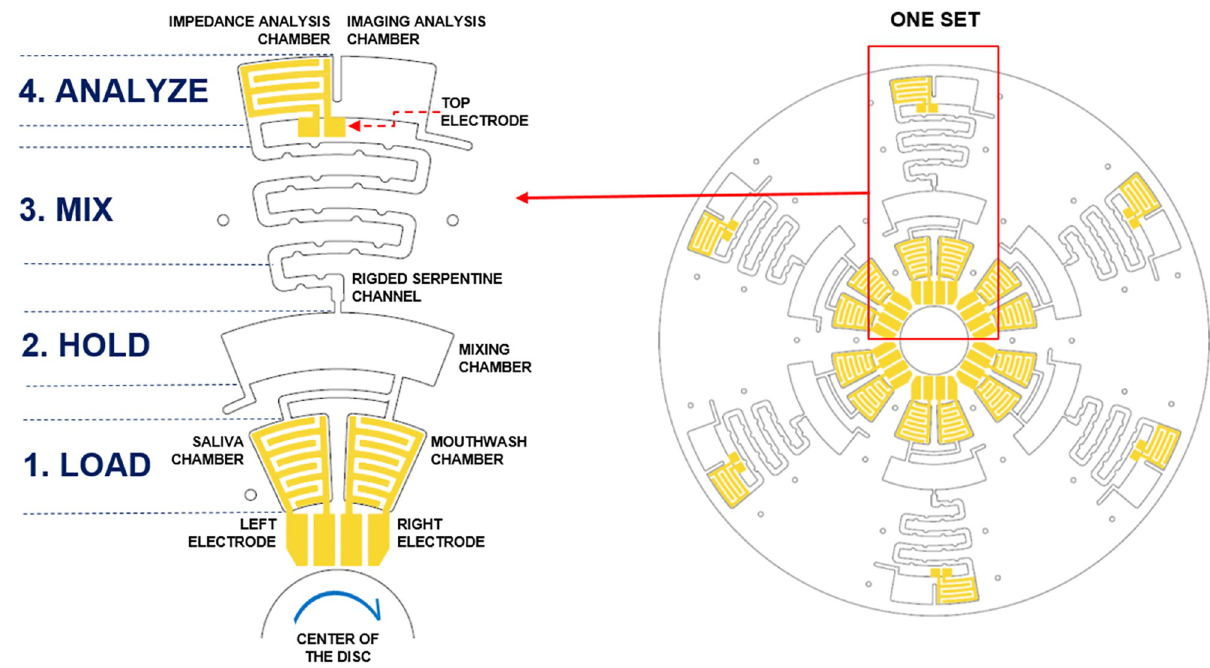
Fig 2. Working design of the microfluidic CD. microfluidic CD design, three sets were assigned for mixing the sequence of real saliva with three different types of mouthwashes. Another three sets were assigned for artificial saliva mixed with three different types of mouthwashes. Real saliva used in the subsequent analysis was taken from the same individual. The sequencing and functionality of each part were divided into four stages; (1) LOAD, (2) HOLD, (3) MIX and (4) ANALYZE, as illustrated in Fig 2. In the first stage (LOAD), the mouthwashes MW1, MW2 and MW3 were mixed with either artificial saliva (AS) or real saliva (RS). Then, the disc was spun to a speed until both solutions entered the HOLD chamber. The speed was slowly increased until the solution in the HOLD chamber burst into the serpentine channel (MIX). The serpentine channel was designed with ridges to enhance the mixing efficiency. The ANALYZE chamber (final stage) was designed to equally separate the solution into two volumes covering the right and left sides of the chamber. The right side with a transparent bottom layer was for sample imaging, whereas the right side was fixed with an embedded electrode for impedance measurement.